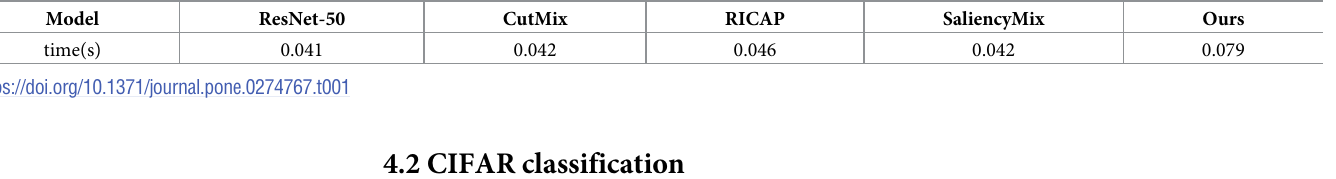
Table 1. Training times of the compared methods on the CIFAR dataset. Model